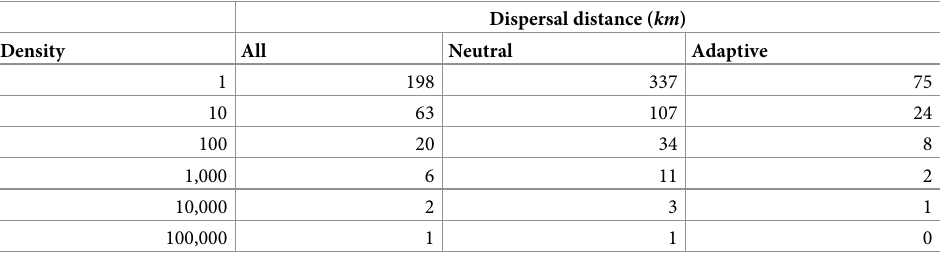
depending on effective population density (adults /